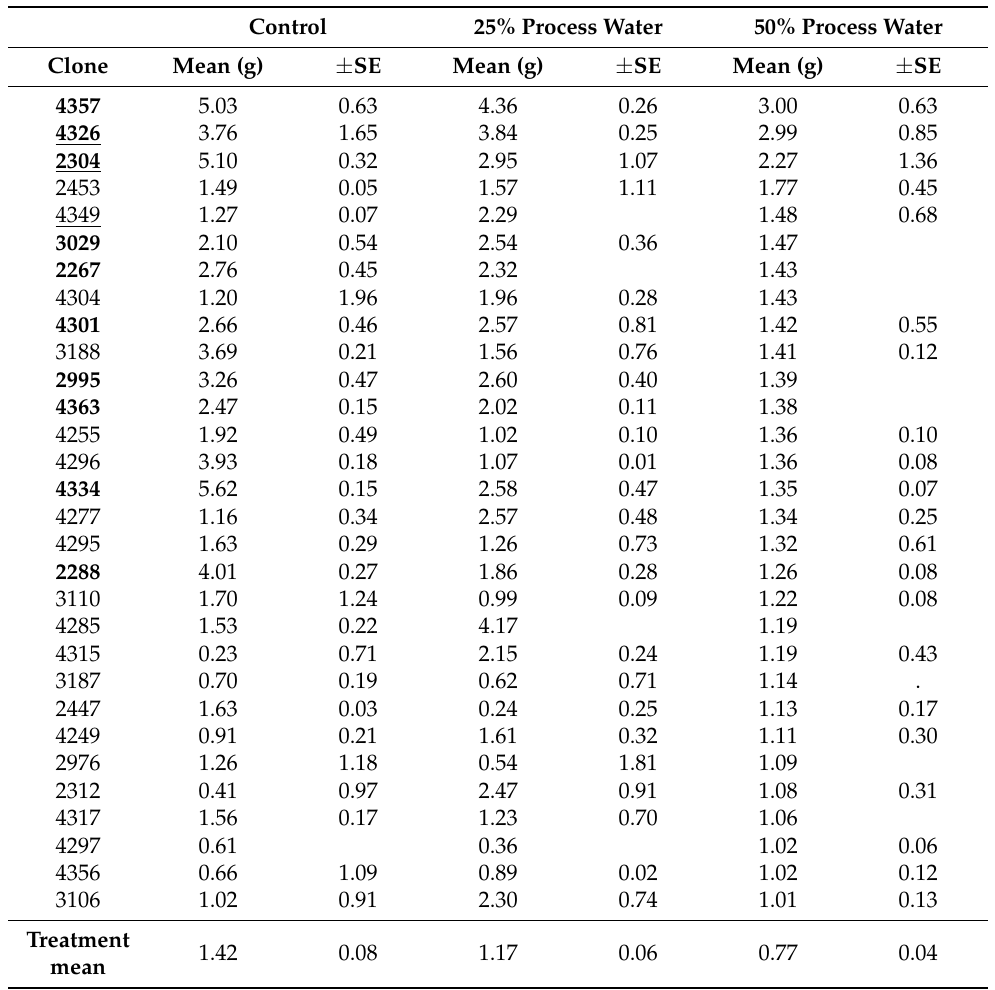
Table A1. Mean total biomass ( ± SE, grams) of the top 30 balsam poplar clones in the 50% process water treatment with corresponding means ( ± SE) for the control and 25% process water treatments in 2012. Clone numbers in bold identify clones that ranked in the top 30 for all three water treat- ments, while underlined clone numbers indicated consistent performance in both years’ experiments. Periods indicate dead